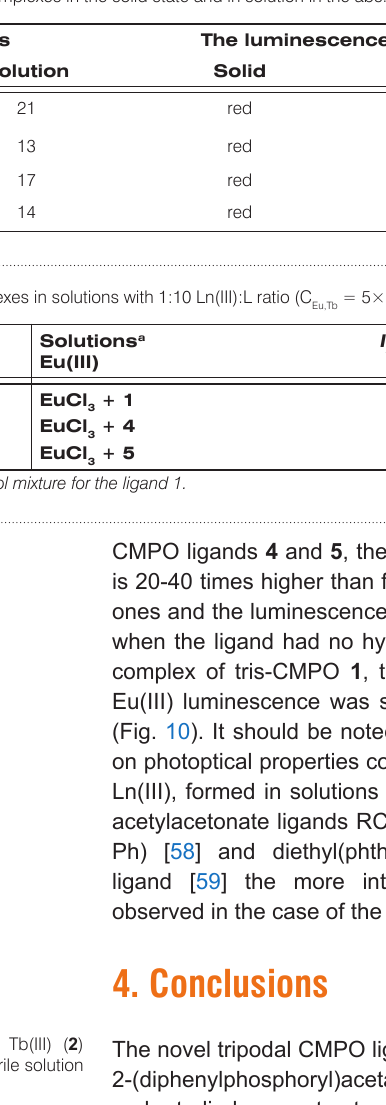
Table 3. Luminescence intensity ( I Eu complex